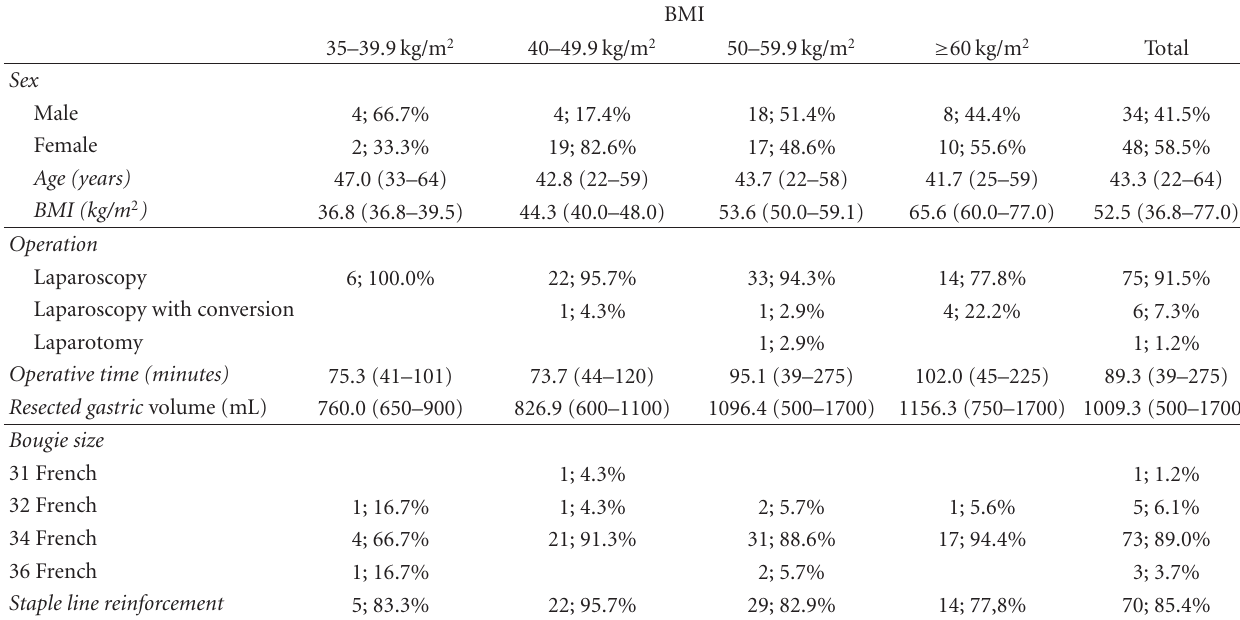
Table 2: Data from patients and